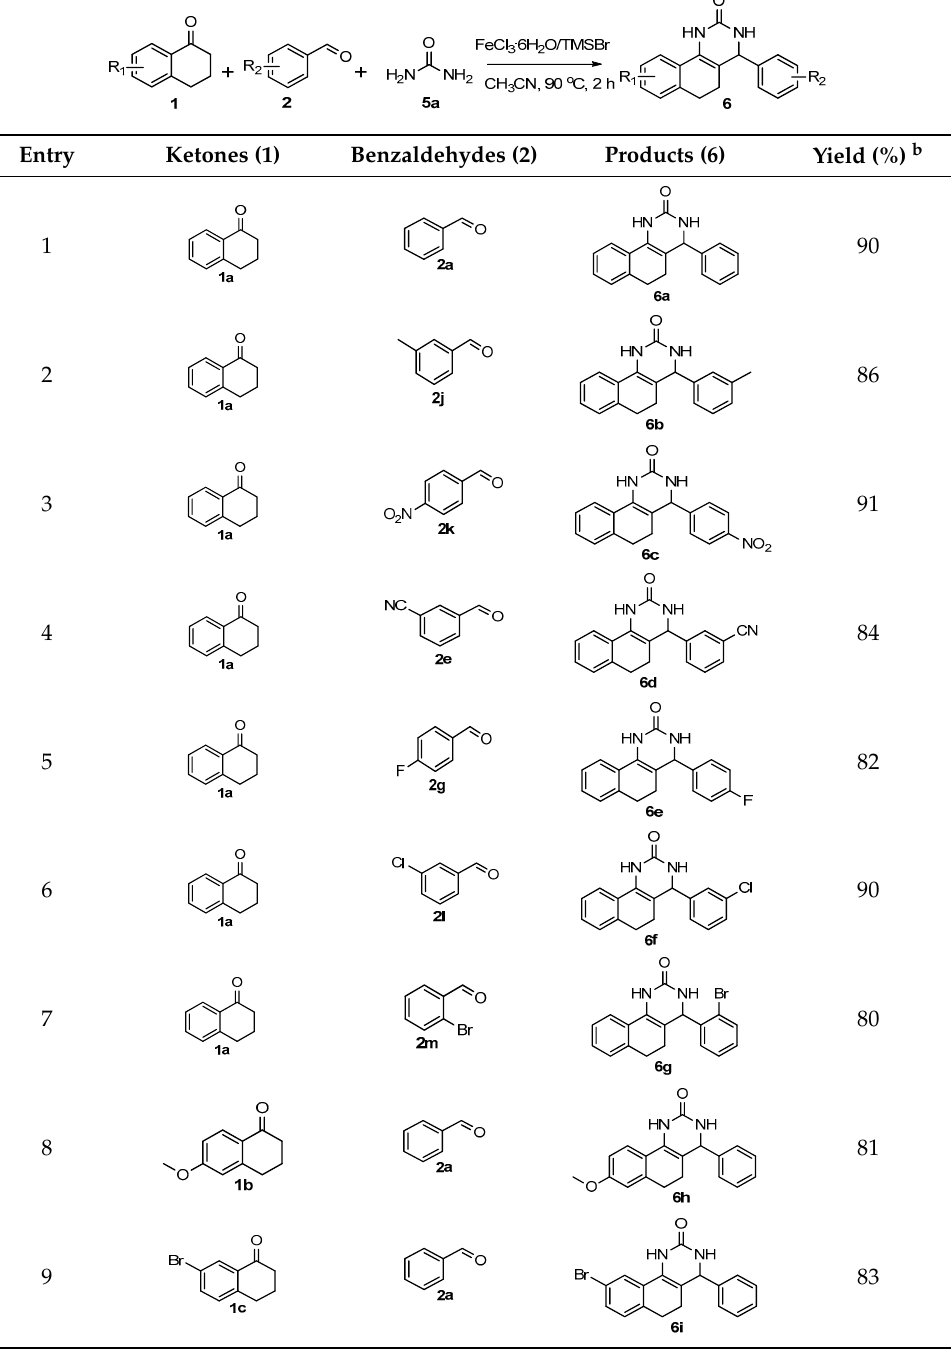
Table 3. FeCl 3 · 6H 2 O/TMSBr-catalyzed synthesis of 3,4-dihydropyrimidin-2(1 H )-ones a . Table 3. FeCl 3 ∙ 6H 2 O/TMSBr-catalyzed synthesis of 3,4-dihydropyrimidin-2(1 H )-ones a . Table 3. FeCl 3 ∙ 6H 2 O/TMSBr-catalyzed synthesis of 3,4-dihydropyrimidin-2(1 H )-ones a . Table 3. FeCl 3 ∙ 6H 2 O/TMSBr-catalyzed synthesis of 3,4-dihydropyrimidin-2(1 H )-ones a . Table 3. FeCl 3 ∙ 6H 2 O/TMSBr-catalyzed synthesis of 3,4-dihydropyrimidin-2(1 H )-ones a . Table 3. FeCl 3 ∙ 6H 2 O/TMSBr-catalyzed synthesis of 3,4-dihydropyrimidin-2(1 H )-ones a . Table 3. FeCl 3 ∙ 6H 2 O/TMSBr-catalyzed synthesis of 3,4-dihydropyrimidin-2(1 H )-ones a . Table 3. FeCl 3 ∙ 6H 2 O/TMSBr-catalyzed synthesis of 3,4-dihydropyrimidin-2(1 H )-ones a . Table 3. FeCl 3 ∙ 6H 2 O/TMSBr-catalyzed synthesis of 3,4-dihydropyrimidin-2(1 H )-ones a . Table 3. FeCl 3 ∙ 6H 2 O/TMSBr-catalyzed synthesis of 3,4-dihydropyrimidin-2(1 H )-ones a . Table 3. FeCl 3 ∙ 6H 2 O/TMSBr-catalyzed synthesis of 3,4-dihydropyrimidin-2(1 H )-ones a . Table 3. FeCl 3 ∙ 6H 2 O/TMSBr-catalyzed synthesis of 3,4-dihydropyrimidin-2(1 H )-ones a . Table 3. FeCl 3 ∙ 6H 2 O/TMSBr-catalyzed synthesis of 3,4-dihydropyrimidin-2(1 H )-ones a . Table 3. FeCl 3 ∙ 6H 2 O/TMSBr-catalyzed synthesis of 3,4-dihydropyrimidin-2(1 H )-ones a . Table 3. FeCl 3 ∙ 6H 2 O/TMSBr-catalyzed synthesis of 3,4-dihydropyrimidin-2(1 H )-ones a . Table 3. FeCl 3 ∙ 6H 2 O/TMSBr-catalyzed synthesis of 3,4-dihydropyrimidin-2(1 H )-ones a . Table 3. FeCl 3 ∙ 6H 2 O/TMSBr-catalyzed synthesis of 3,4-dihydropyrimidin-2(1 H )-ones a . Table 3. FeCl 3 ∙ 6H 2 O/TMSBr-catalyzed synthesis of 3,4-dihydropyrimidin-2(1 H )-ones a . Table 3. FeCl 3 ∙ 6H 2 O/TMSBr-catalyzed synthesis of 3,4-dihydropyrimidin-2(1 H )-ones a . Table 3. FeCl 3 ∙ 6H 2 O/TMSBr-catalyzed synthesis of 3,4-dihydropyrimidin-2(1 H )-ones a . Table 3. FeCl 3 ∙ 6H 2 O/TMSBr-catalyzed synthesis of 3,4-dihydropyrimidin-2(1 H )-ones a . Table 3. FeCl 3 ∙ 6H 2 O/TMSBr-catalyzed synthesis of 3,4-dihydropyrimidin-2(1 H )-ones a . Table 3. FeCl 3 ∙ 6H 2 O/TMSBr-catalyzed synthesis of 3,4-dihydropyrimidin-2(1 H )-ones a . Table 3. FeCl 3 ∙ 6H 2 O/TMSBr-catalyzed synthesis of 3,4-dihydropyrimidin-2(1 H )-ones a . Table 3. FeCl 3 ∙ 6H 2 O/TMSBr-catalyzed synthesis of 3,4-dihydropyrimidin-2(1 H )-ones a . Table 3. FeCl 3 ∙ 6H 2 O/TMSBr-catalyzed synthesis of 3,4-dihydropyrimidin-2(1 H )-ones a